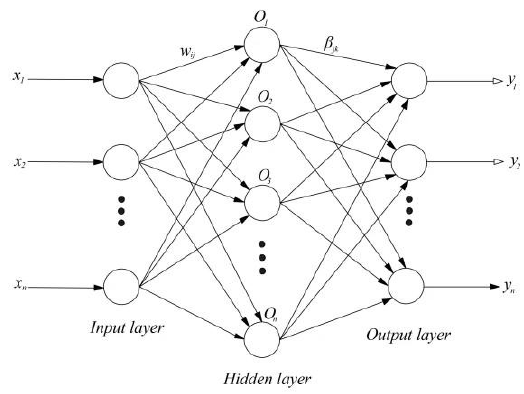
Figure 10. General structure diagram.